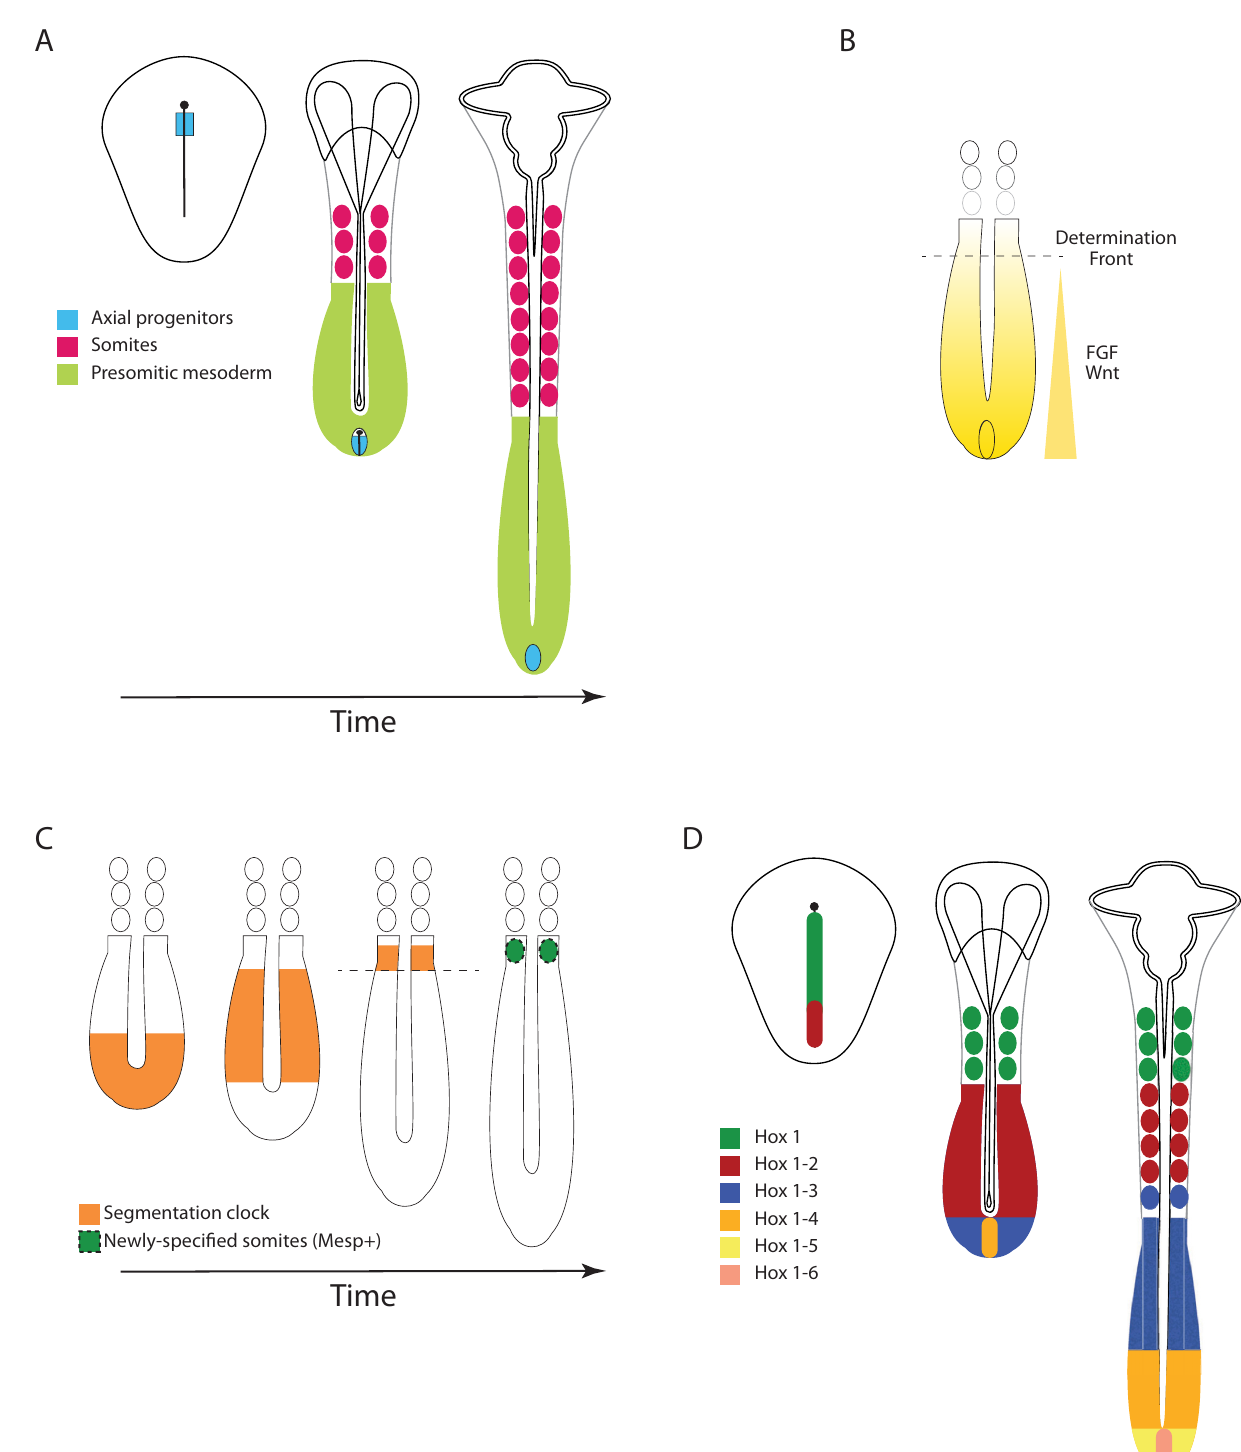
Fig 1. Gene expression patterns in vertebrates. (A) Morphogenesis in the chicken embryo. Left: Epiblast stage. The primitive streak is shown as a vertical line with the node on the top. Axial progenitors (blue) are located in the anterior region of the primitive streak. Middle panel: 3-somite stage. Paraxial mesoderm is segmented into somites (pink) anteriorly, but unsegmented posteriorly (PSM; green). Axial progenitors (blue) are located in the regressing primitive streak at the posterior end of the embryo, where axial elongation takes place. Right panel: 8-somite stage. Somites (pink) continue to from sequentially from the PSM (green), as the embryo elongates posteriorly. (B) Signaling gradients in somitogenesis. FGF and Wnt signaling